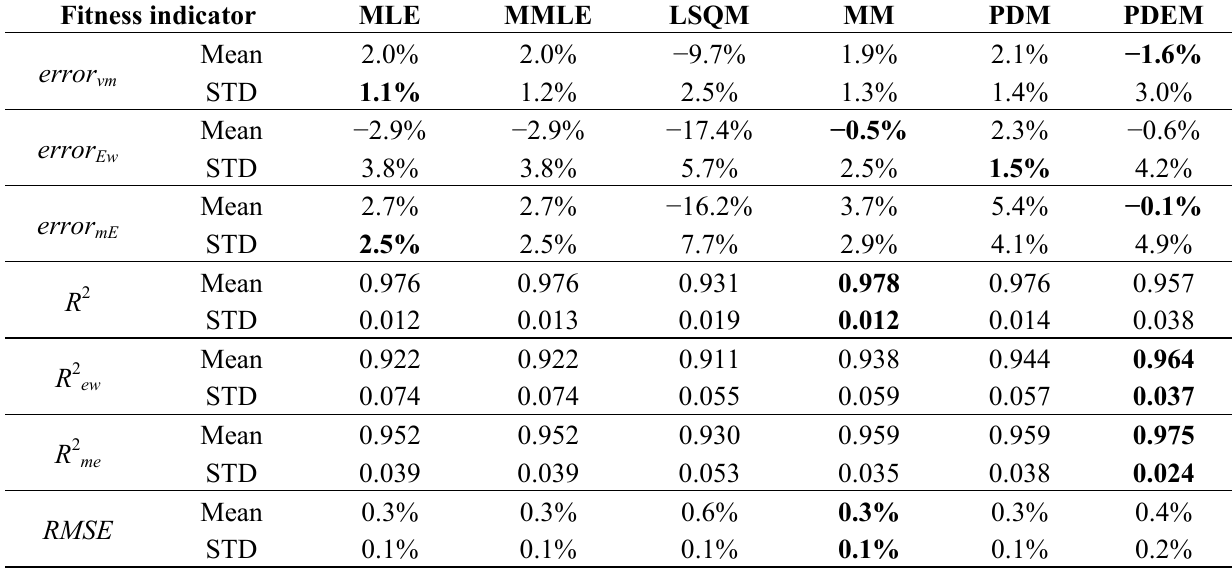
Table 3. Summary of the results (best values of the mean and standard deviation (STD) for each fitness indicator are displayed in